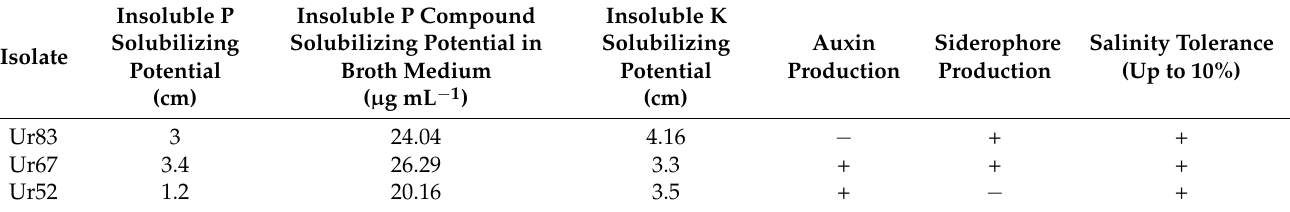
Table 2. PGPR and salinity-resistance tests of the selected isolates.